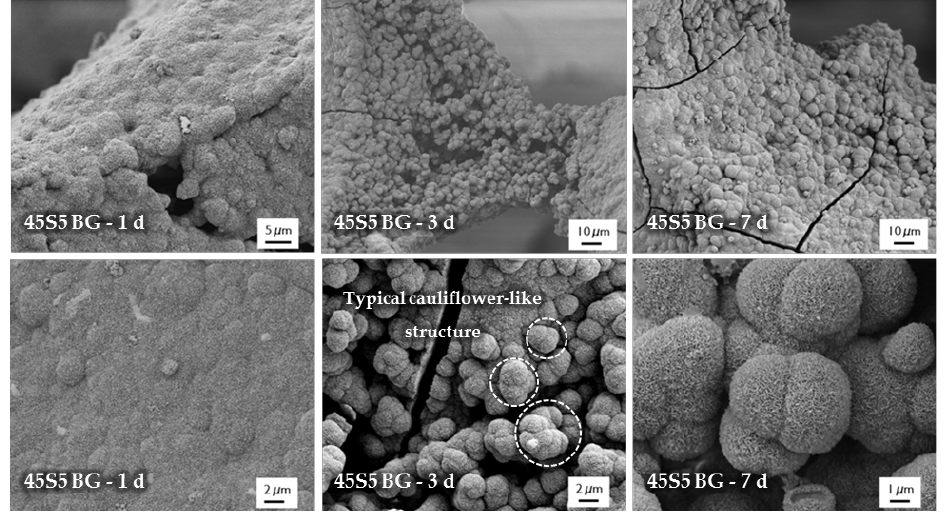
Figure 6. SEM images of as-fabricated 45S5 BG-based samples after immersion in simulated body fluid (SBF) for 1, 3, and 7 days (at different magnifications). Int. J. Mol. Sci. 2018 , 19 , x FOR PEER REVIEW